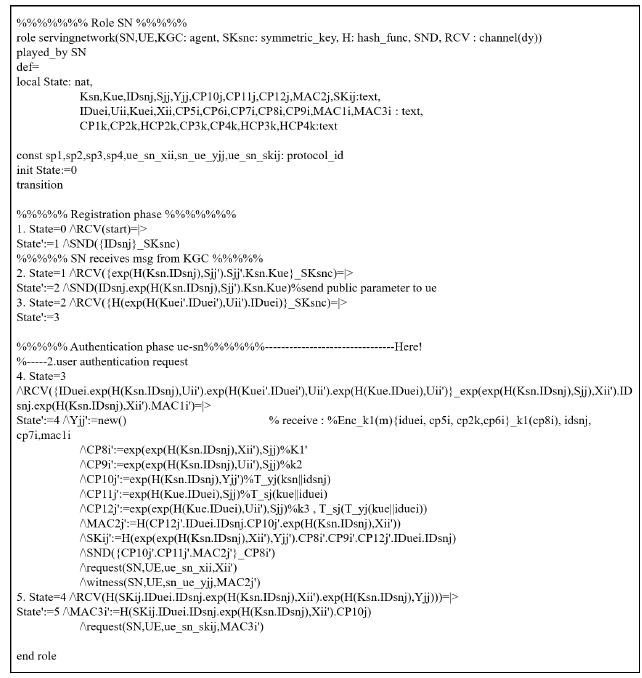
Figure 3. Scenario 1: HLPSL description of SN